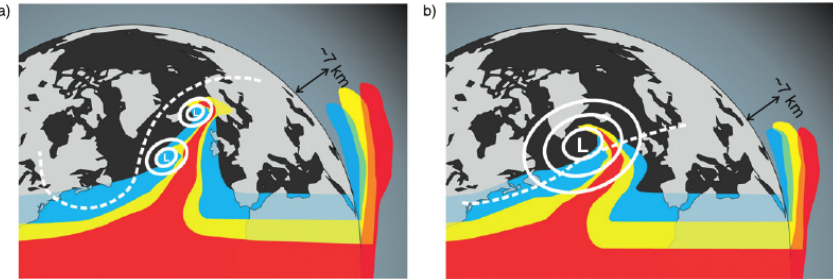
Figure 3. Schematic view of the two moisture transport configurations. (a) Anticyclonic (LC1-like) wave breaking with a meridional upper- level jet and (b) cyclonic (LC2-like) wave breaking with a zonal upper-level jet. Dashed white line shows the orientation of the upper-level jet, solid white lines show SLP, and shaded colors indicate oceanic moisture of different latitudes. On the right-hand side, quasi-vertical projections of the moisture tracers are shown. (Fig. 10 in Sodemann and Stohl, 2013; used with permission © American Meteorological Society.)